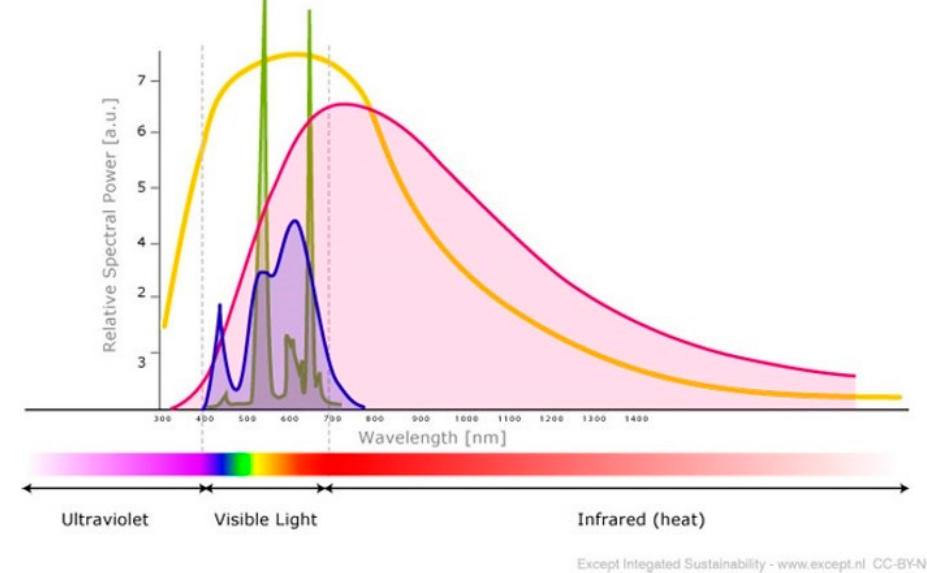
Figure 2. Diagram of the spectrum a LED lamp (blue), a CFL (green) and an incandescent (purple) superimposed the solar spectrum (yellow).